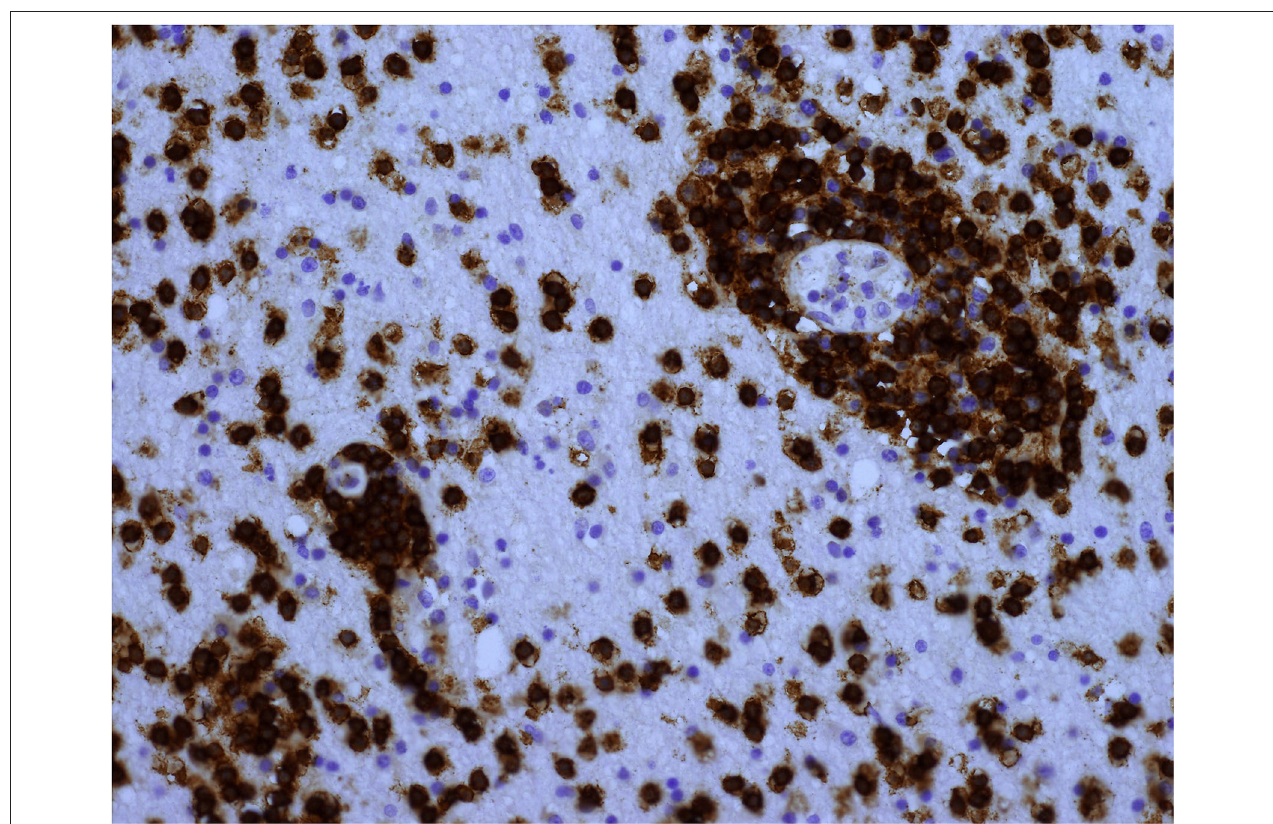
FIGURE 7 | Cerebral white matter CD8 + T-cells: the highest density seen in a UK patient. Original magnification × 400.